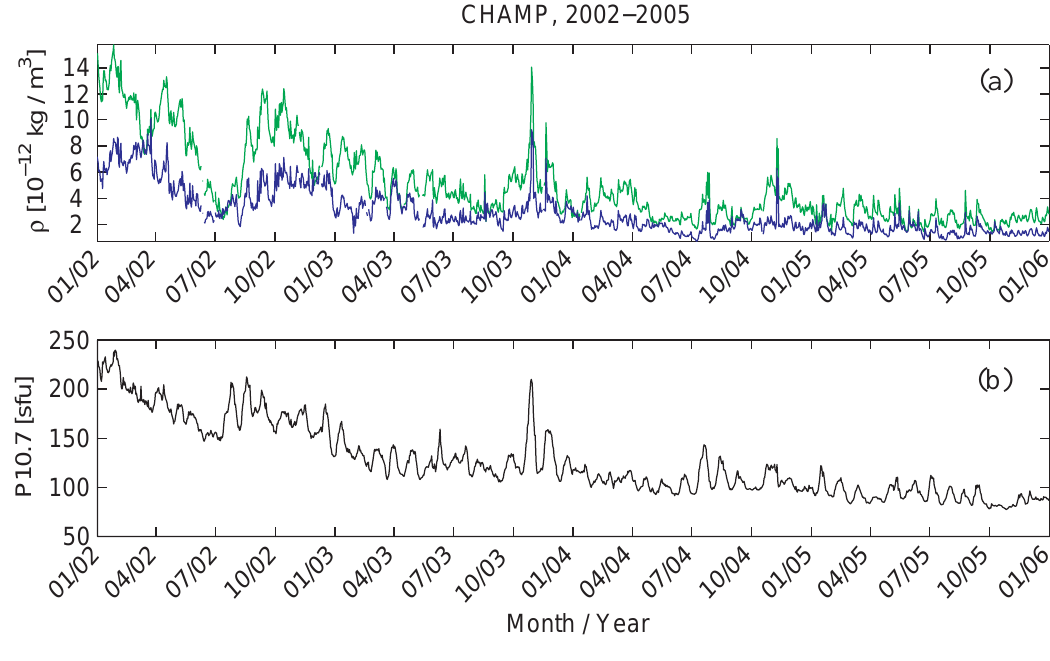
Fig. 2. (a) Daily mean density variations for the considered period (2002–2005). The green curve shows air density on the day side and the blue curve on the night side. (b) Plot of the solar flux variation (P10.7) for the same